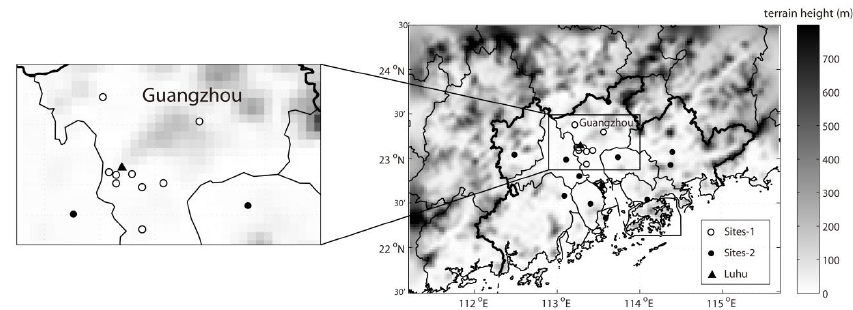
Fig. 1. Geographical map of the Pearl River Delta region and location of air quality monitoring sites. (Sites-1: sites from Guangzhou National Control Network; Sites-2: sites from PRD Regional Air Quality Monitoring Network; Luhu: Luhu site.)